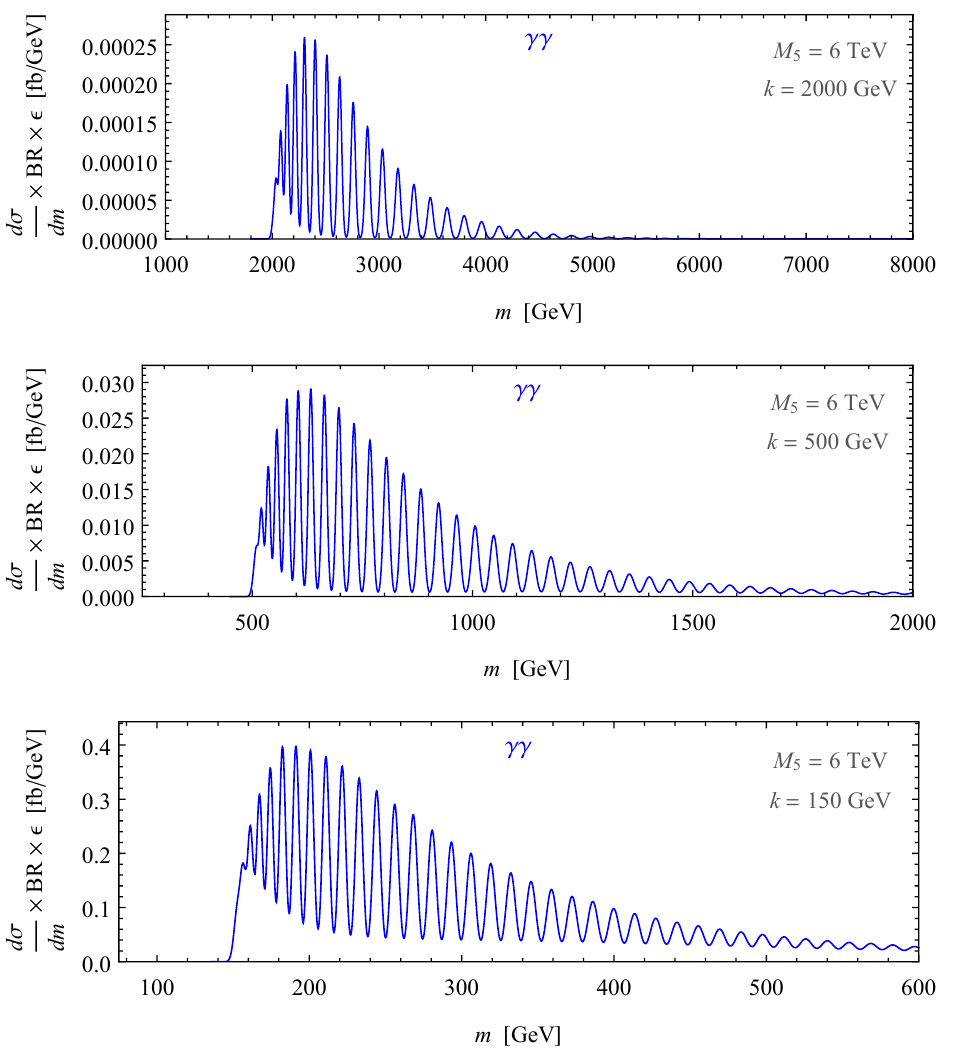
Figure 12 . Signal in the diphoton spectrum at the 13 TeV LHC for M 5 = 6 TeV and k = 2000, 500, 150 GeV (from top to bottom) after accounting for the experimental resolution, eq. (3.1). channel, the peaks will merge into a broad excess due to the low resolution in m which is roughly between 5% and 10% in the relevant range of masses [63,